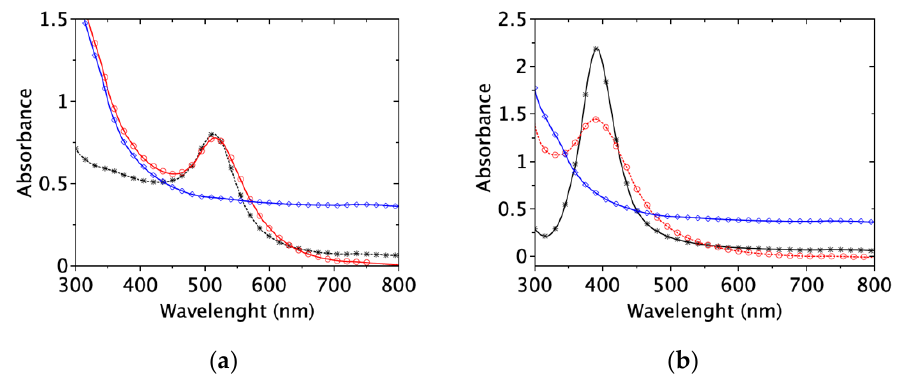
Figure 5. UV-visible spectra of 256 µmol/L of ( a ) AuNPs and ( b ) AgNPs in (*) water, in ( ) CA-MHB, and in (◊) CA-MHB after 24 h at 35 °C.